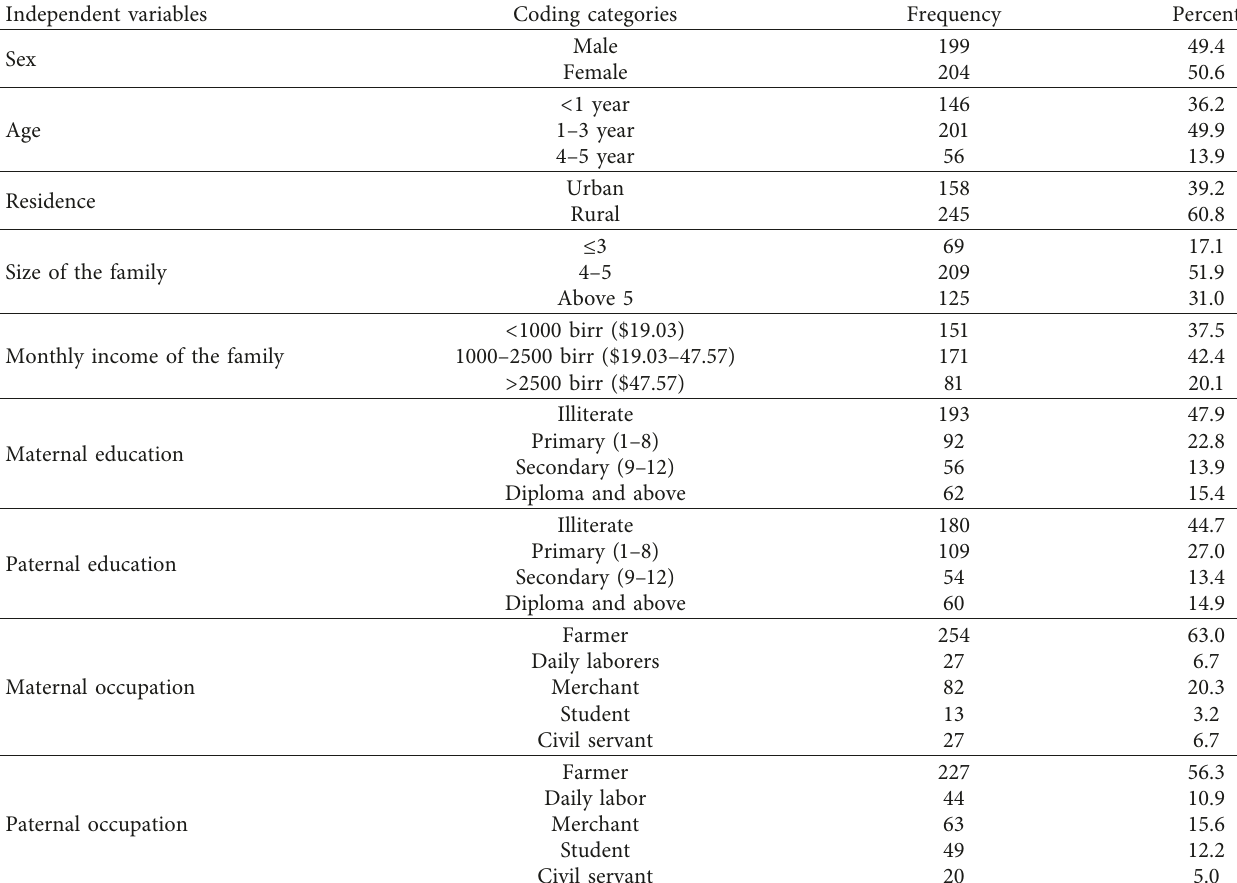
Table 1: Sociodemographic characteristics of the respondents in Goncha Siso Enesie District, Northwest Ethiopia ( n � 403). Independent